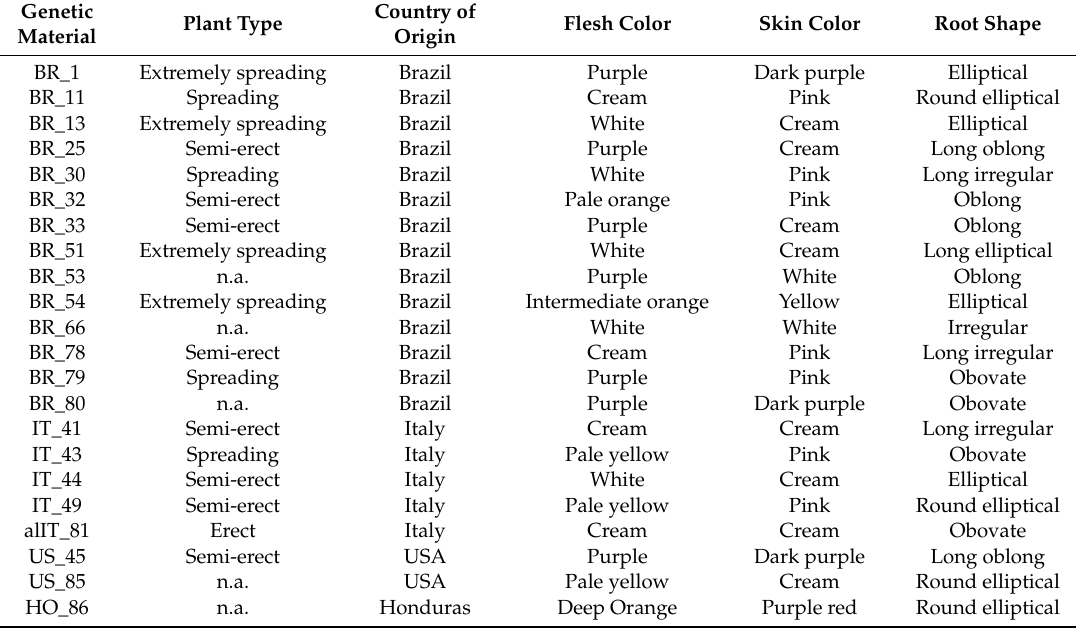
Table 1. List of sweet potato genotypes